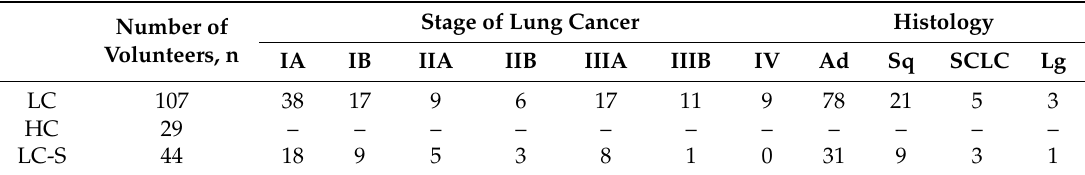
Number of volunteers, stage, and histology of lung cancer samples for gas condenser-GC/MS